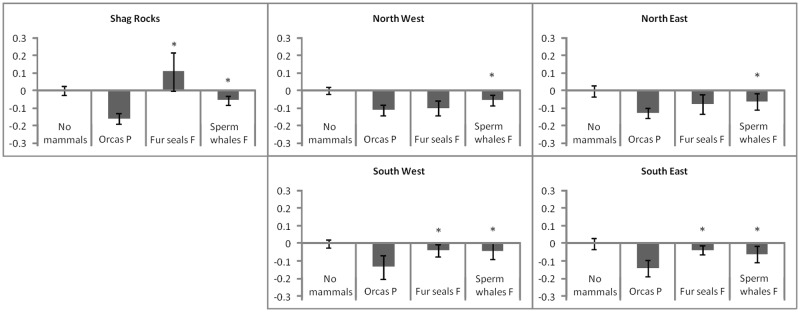
Difference in catch rates under various depredation scenarios.Mean difference (Tukey’s honest statistical difference) in catch rates of the three main mammal scenarios to the no-mammal scenario around South Georgia. P—present, F—feeding. Originally 21 scenarios were calculated (orcas, sperm whales, fur seals: present/ absent, feeding/not feeding, and combinations of these) and the three most damaging scenarios to catch rates were chosen to be graphically represented. No-mammal-scenario average catch rates: Shag rocks = 300±0.06 g, North West = 233±0.05 g, North East = 276±0.07 g, South West = 253±0.05 g, and South East = 272±0.08 g of toothfish/hook. Stars denote difference between mammal scenarios.